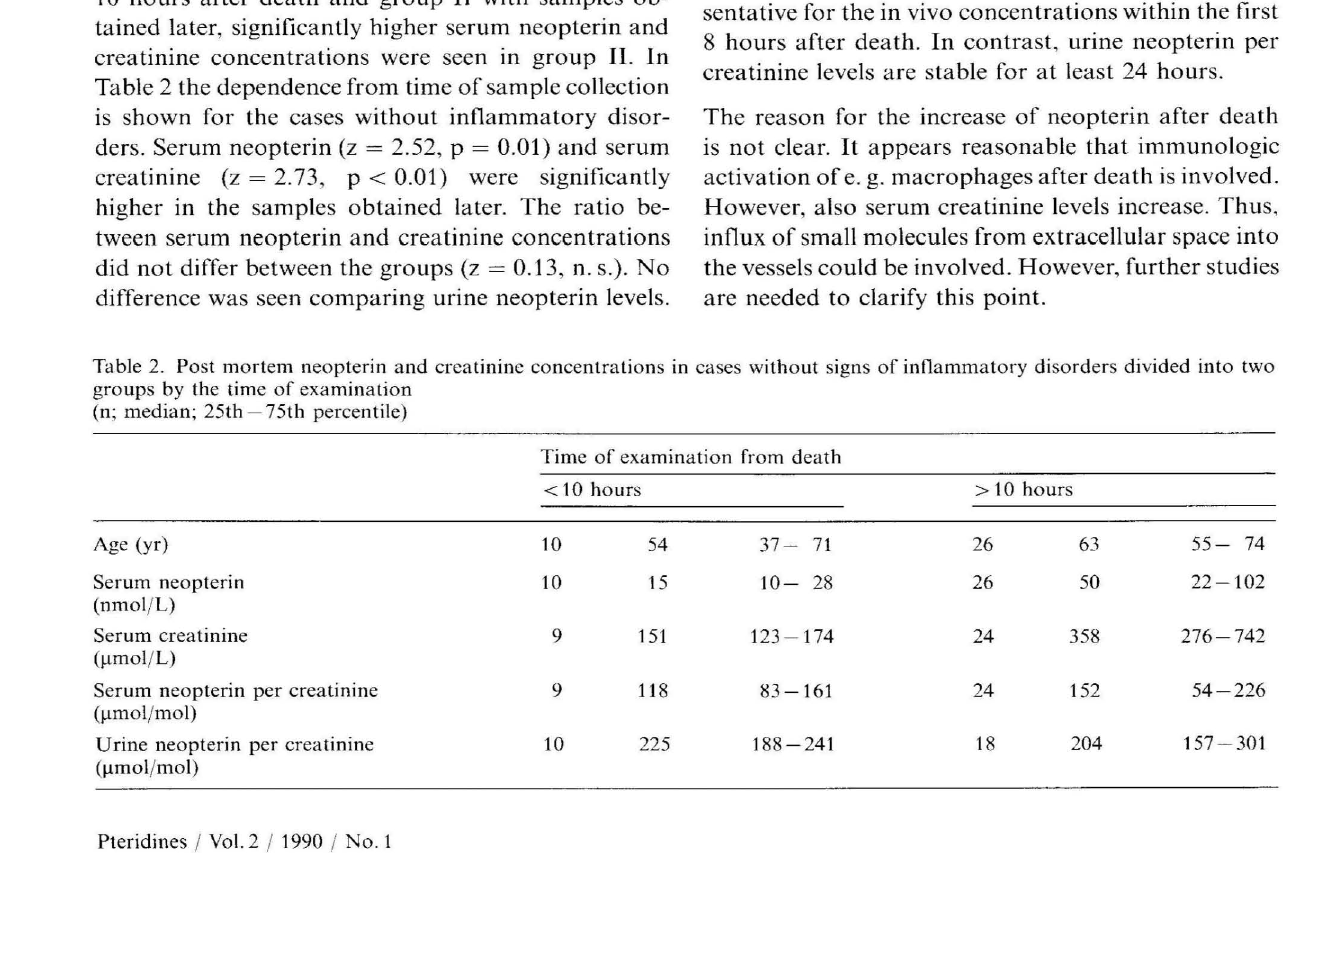
Table 2. Post mortem neopterin and creatinine concentrations in cases without signs of inflammatory disorders divided into two groups by the time of examination (n; median; 25th - 75th percentile)